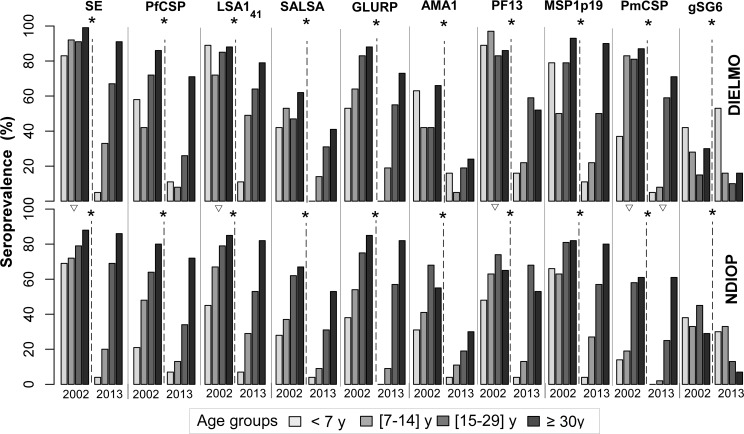
Seroprevalence observed for the panel of antigens studied during the July 2002 andJuly 2013 cross-sectional surveys conducted in Dielmo and Ndiop, by age group.Seroprevalence (percent positive individuals within each age group) to the set of antigens used are shown as bar plot for Dielmo (upper part) and Ndiop (lower part) in 2002 and 2013 for the different age groups <7y (white), 7–14 y (light grey), 15–29 y (dark grey and ≥30 y (black). Asterisks indicate a significant decrease of antibody prevalence within each community between 2002 and 2013 (P<10−2). Triangles indicate a significant inter-village difference of prevalence against SE, LSA141, PF13, PmCSP in 2002 and PmCSP in 2013. The number of individuals within each age group for each survey and the P values of the various comparisons are presented in the S1 Table.